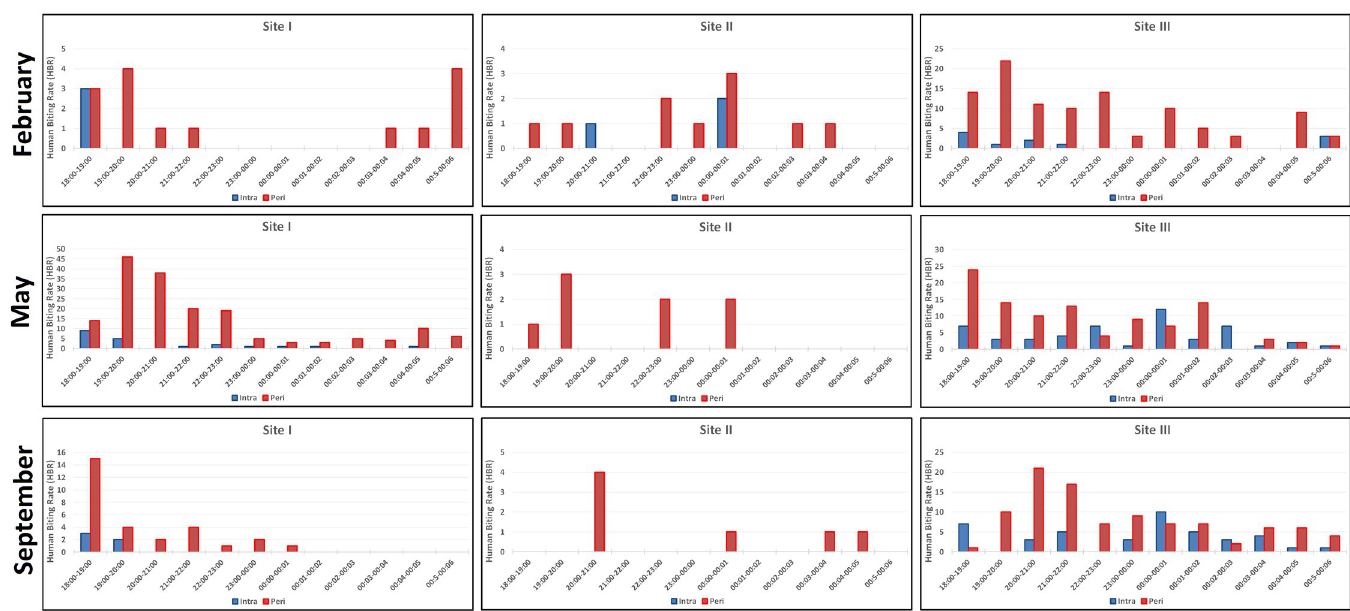
Fig 4. Blood-feeding pattern by human biting rate (HBR: Ny . darlingi per human captures per hour), by night-capture, site and